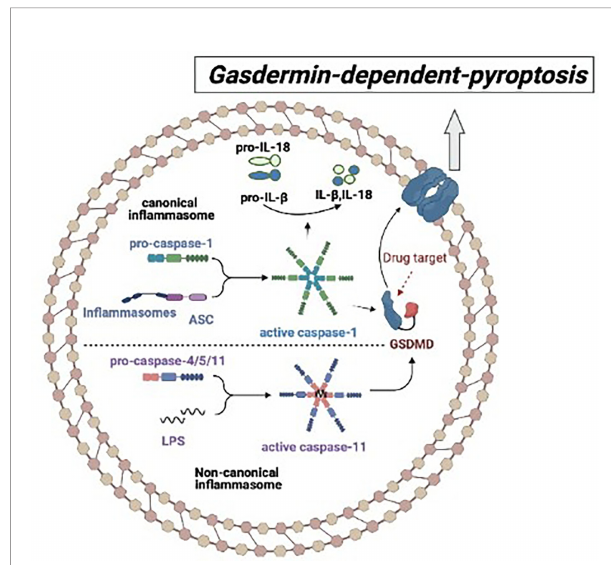
FIGURE 1 | The mechanism of gasdermin-dependent-pyroptosis: In the canonical pyroptosis pathway, ASC recruits intracellular pro-Caspase-1 to bind to the in fl ammatory complex, and then pro-caspase-1 auto-cleaves into activated Caspase-1, which cleaves GSDMD and promotes IL-1 b and IL-18 to maturate. In the non-canonical pyroptosis pathway, in fl ammatory stimulators such as lipopolysaccharide (LPS) directly bind to Caspase-4/5/11 and cause oligomeric activation of Caspase-4/5/11, activated Caspase-4/5/ 11 cleaves GSDMD and triggers